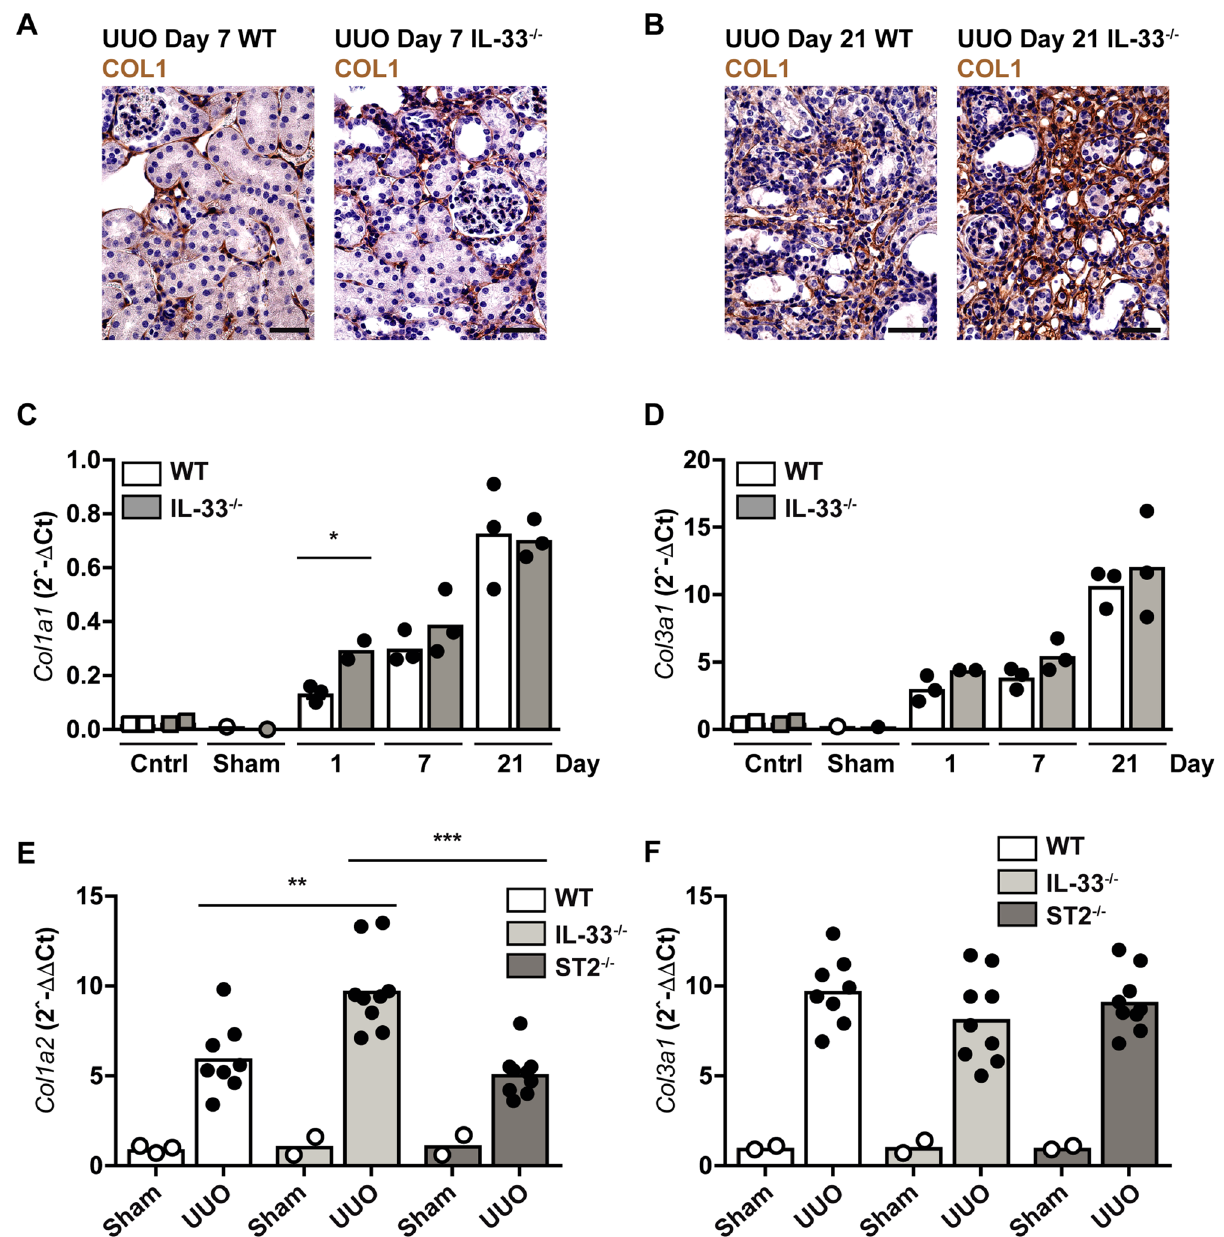
Figure 2. Collagen expression in IL-33 −/− and wildtype kidney during UUO. ( A , B ) Representative photomicrographs of tissue sections stained for COL1 (brown) in kidneys from IL-33 −/− and WT mice 7 and 21 days after UUO. ( C , D ) Time course comparing mRNA transcription of Col1a1 and Col3a1 in IL-33 −/− and WT mice, showing healthy control mice (n = 2), sham-operated mice (n = 1) and mice subjected to UUO 1, 7, or 21 days previously (n = 3 at each time point and of each genotype). ( E , F ) Comparison of Col1a1 and Col3a1 transcription in kidneys from IL-33 −/− , ST2 −/− and WT mice 4 days after sham-operation (n = 5 per genotype) or UUO (n = 10 per genotype). Transcription levels were quantified by qRT-PCR of mRNA. Data points represent individual mice, bars show mean values. *p < 0.05, **p < 0.01, ***p <